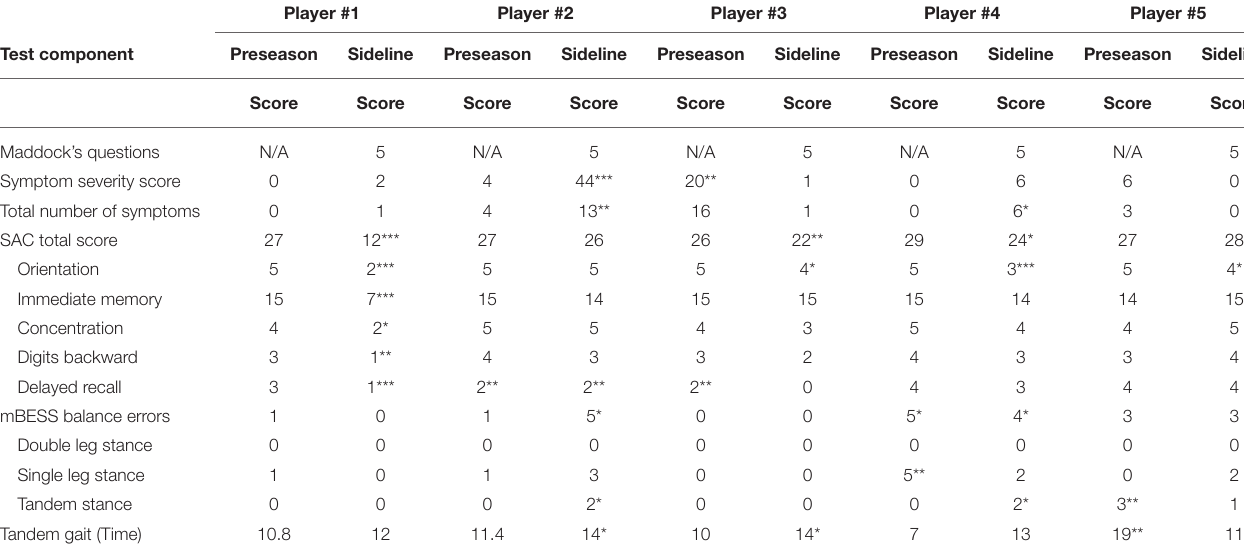
TABLE 7 | Examples of preseason and sideline SCAT5 scores in five women medically diagnosed with